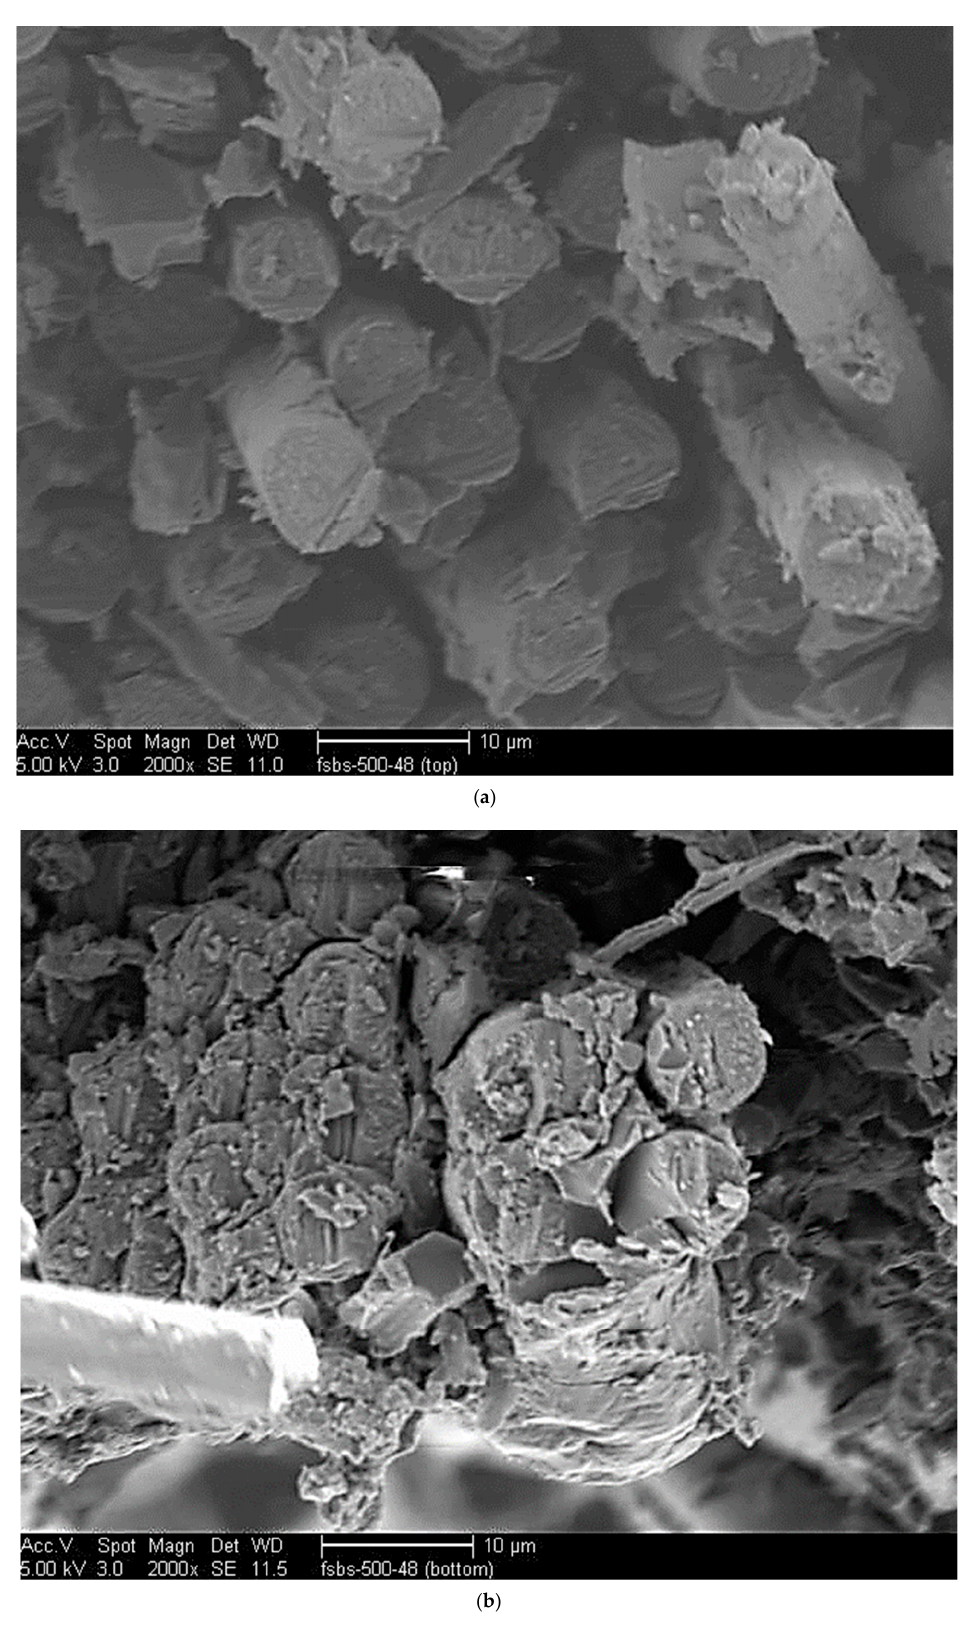
Figure 9. ( a ) SEM Image of SBS specimen near the top surface after testing after 48 h of exposure at 260 °C; ( b ) SEM Image of SBS specimen near the top surface after testing after 48 h of exposure at 260 °C.